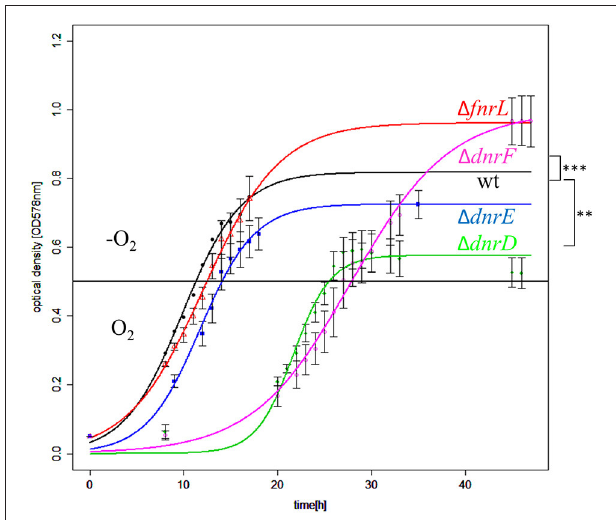
FIGURE 4 | Growth behavior of D. shibae Dfl12 T and oxygen regulatory mutants during an aerobic to anaerobic shift. D. shibae DFL12 T wildtype strain (black line), DS001( ∆ fnrL ) (red line), DS002( ∆ dnrD ) (green line), DS003( ∆ dnrE ) (blue line) and DS004( ∆ dnrF ) (magenta line) mutant strains were grown under aerobic conditions in artificial see water medium supplemented with 16.9 mM succinate. After reaching of OD 578 nm of 0.5 cells were shifted to anaerobic growth conditions (black horizontal line) and 25 mM sodium nitrate was added. The optical density was measured in three independent replicates and error bars represent the standard deviation. P -values were determined by using ANOVA without a Post-hoc -test using the wild type values as reference. The symbols indicate P -values smaller or equal to 0 (***) or 0.001 (**).